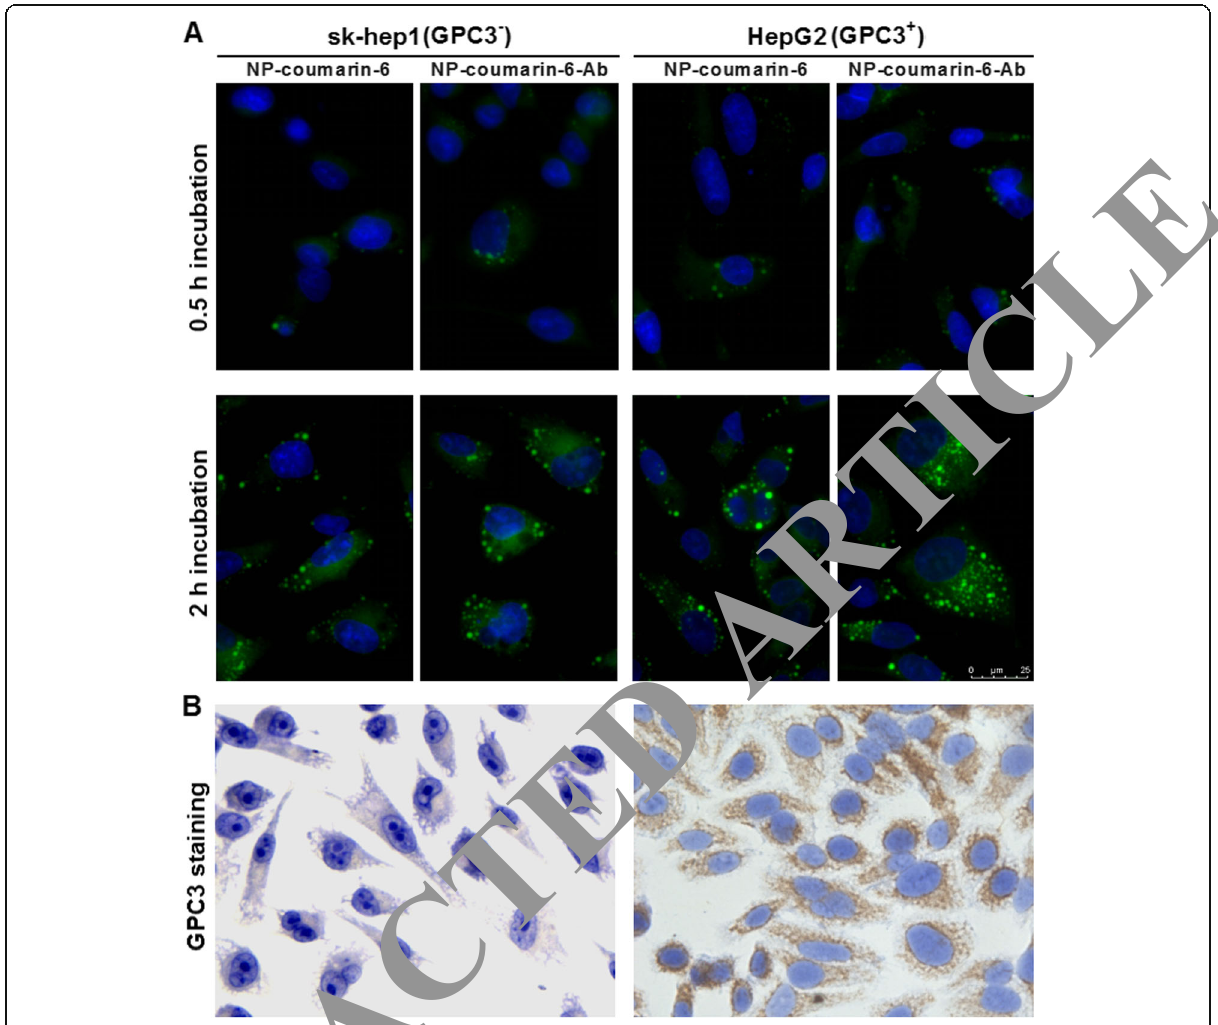
Fig. 3 GPC3 cell expression and selective cellular uptake of NPs and NP-Ab. a Photomicrographs of the uptake of NPs-coumarin 6-Ab and NPs- coumarin 6 by HepG2 cells and SK-hep1 cells. b GPC3 immunocytochemistry of SK-hep1 cells and HepG2 cells, sk-hep1 cells were GPC3-negative cells (left), while HepG2 cells were GPC3-positive